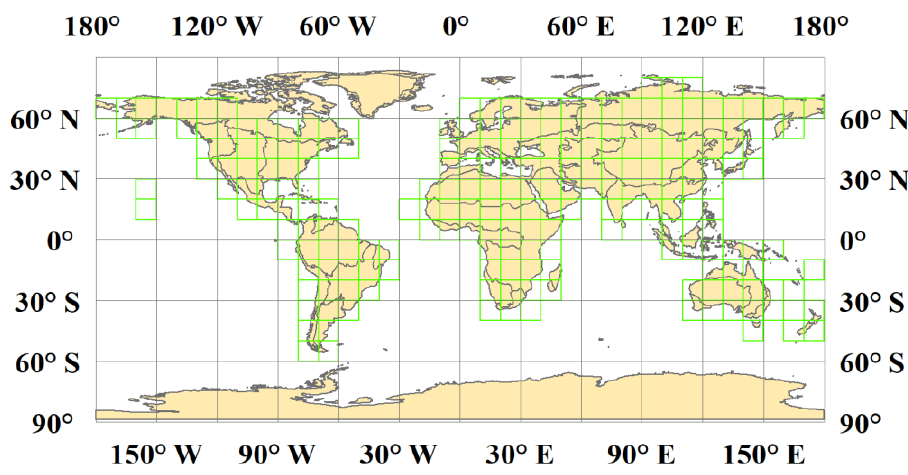
Figure 2. Data distribution of global urban land cover. Table 1. Global urban land-cover data legends for the classification